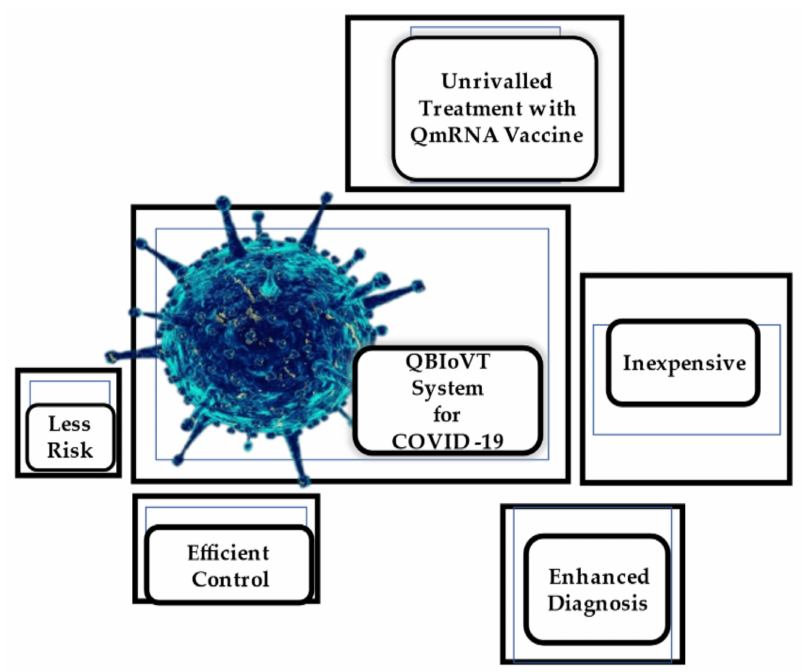
Figure 10. Merits of the IoVT technology for COVID-19